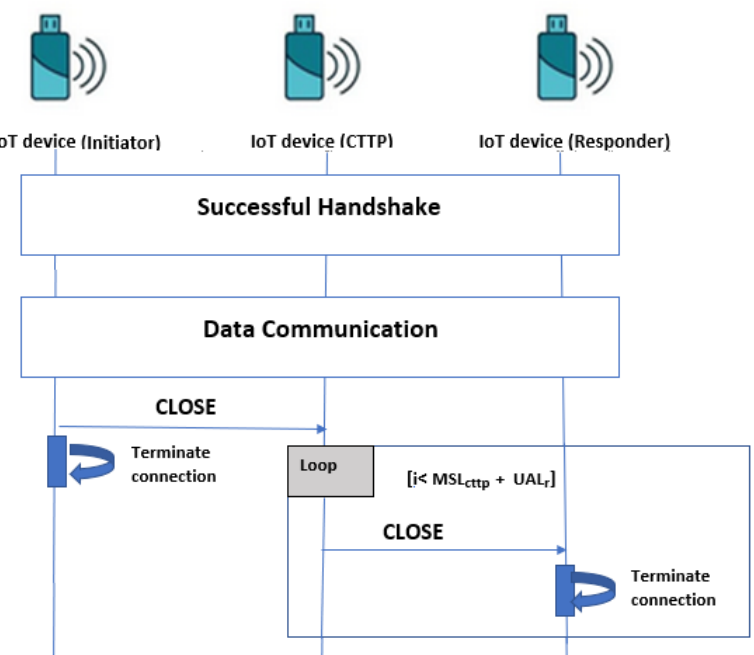
Figure 6. Proposed HIP association